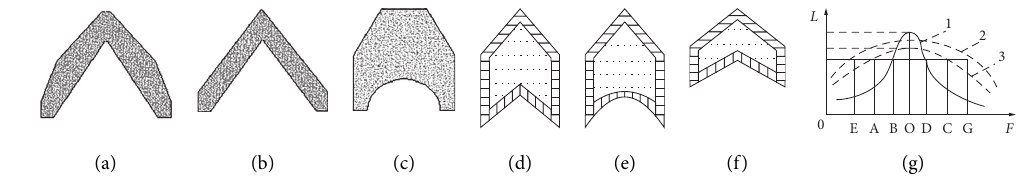
Figure 1: Structure of the shaped charge. (a) At the highest jet energy utilization rate. (b) At the highest jet head velocity. (c) To reduce the interference of the sparse wave, the abrupt change points of the shell shape are selected at a slightly inclined position and at the apex of the shell. (d–g) Shape of the tip can cause the detonation pressure to increase uniformly and produce a localized high-pressure effect; cutting depth can be maintained within a large blasting height range [24,